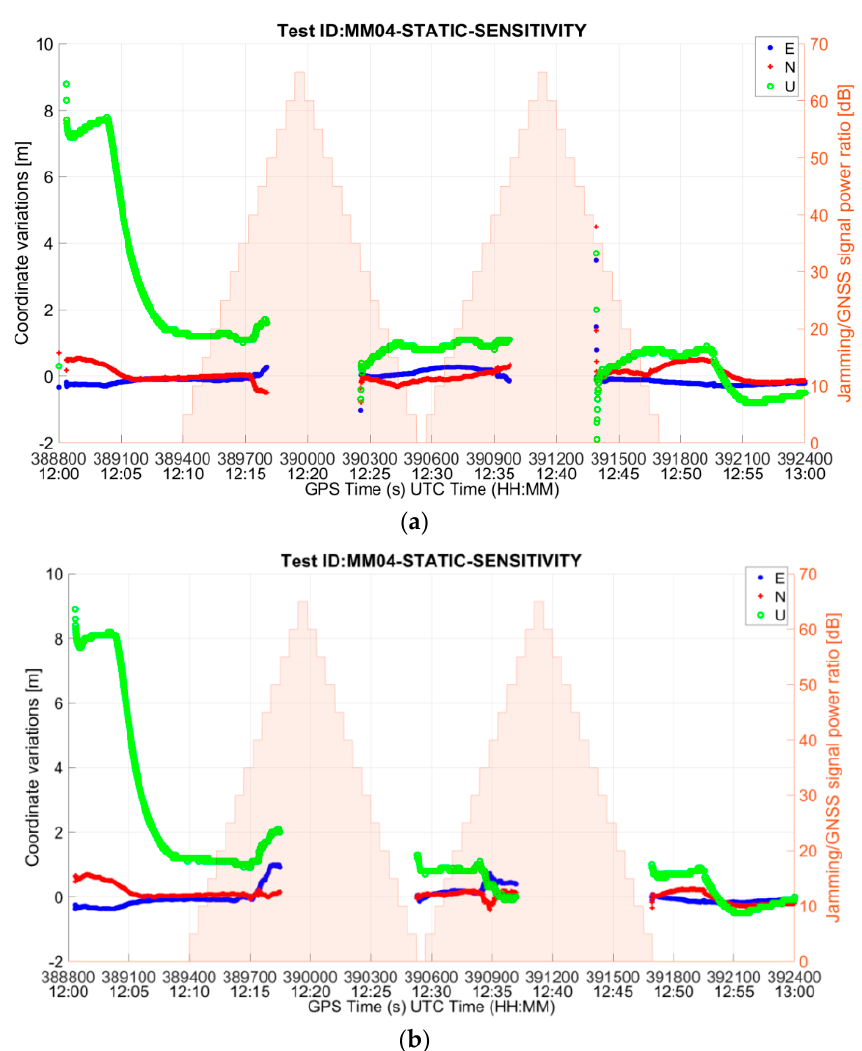
Figure 10. East-North-Up deviations for test case MM04-STATIC-SENSITIVITY using ( a ) recorded interference and ( b ) synthetic interference.